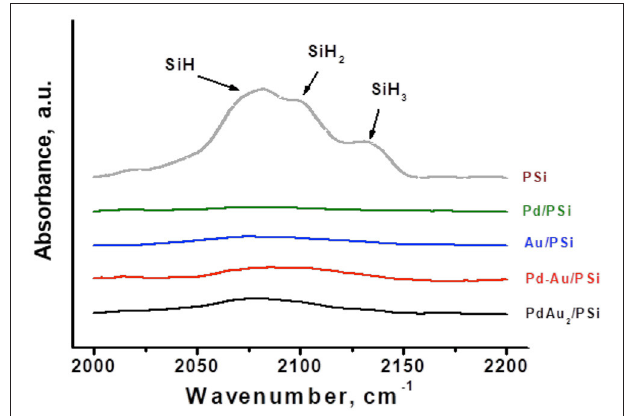
FIGURE 2 | The IR-spectra of PSi support and Pd/PSi, Au/PSi, Pd-Au/PSi, and PdAu 2 /PSi catalysts.